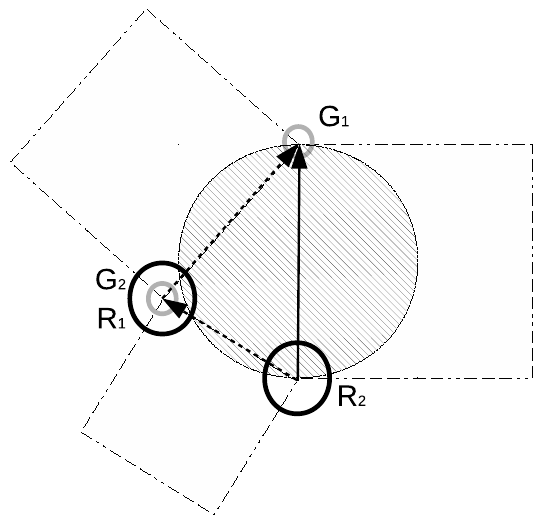
Figure 9. Two robot-goal assignment—case 3.